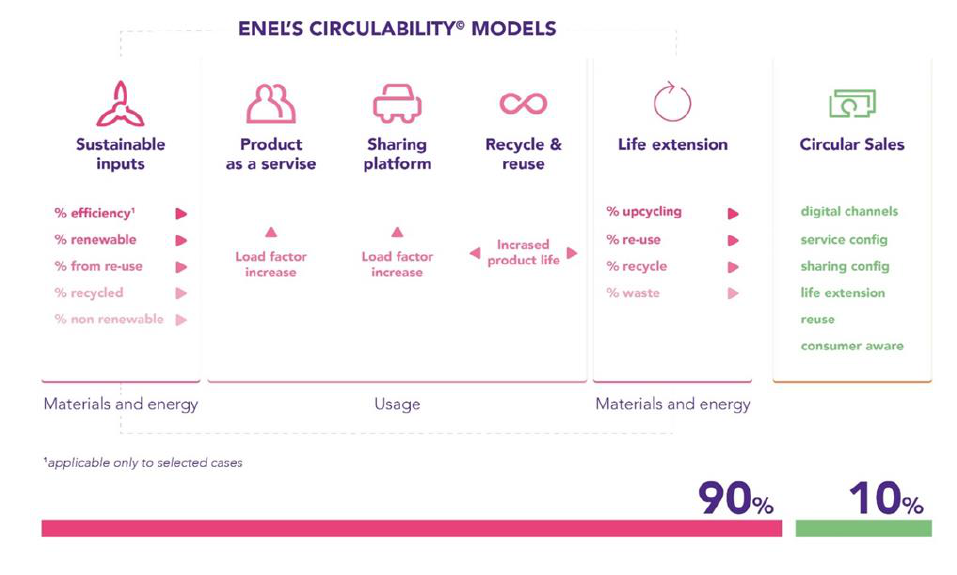
Figure 3: Enel X’s Circular Economy